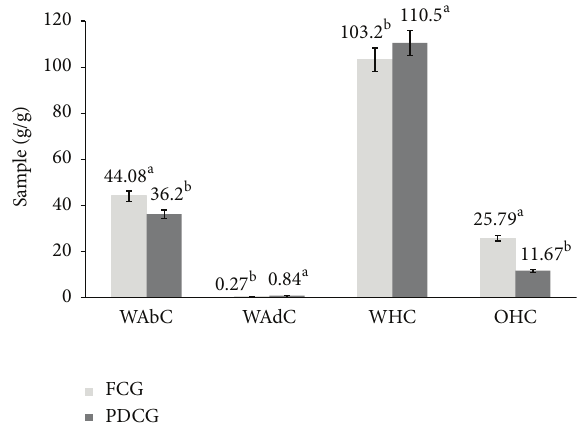
Figure 1: Functional properties of fatted and partly defatted chia gum. Water absorption capacity (WAbC), water adsorption capacity (WAdC), water holding capacity (WHC), and oil holding capacity (OHC). a-b Different superscript letters in the same property indicate statistical difference ( 𝑃 < 0.05